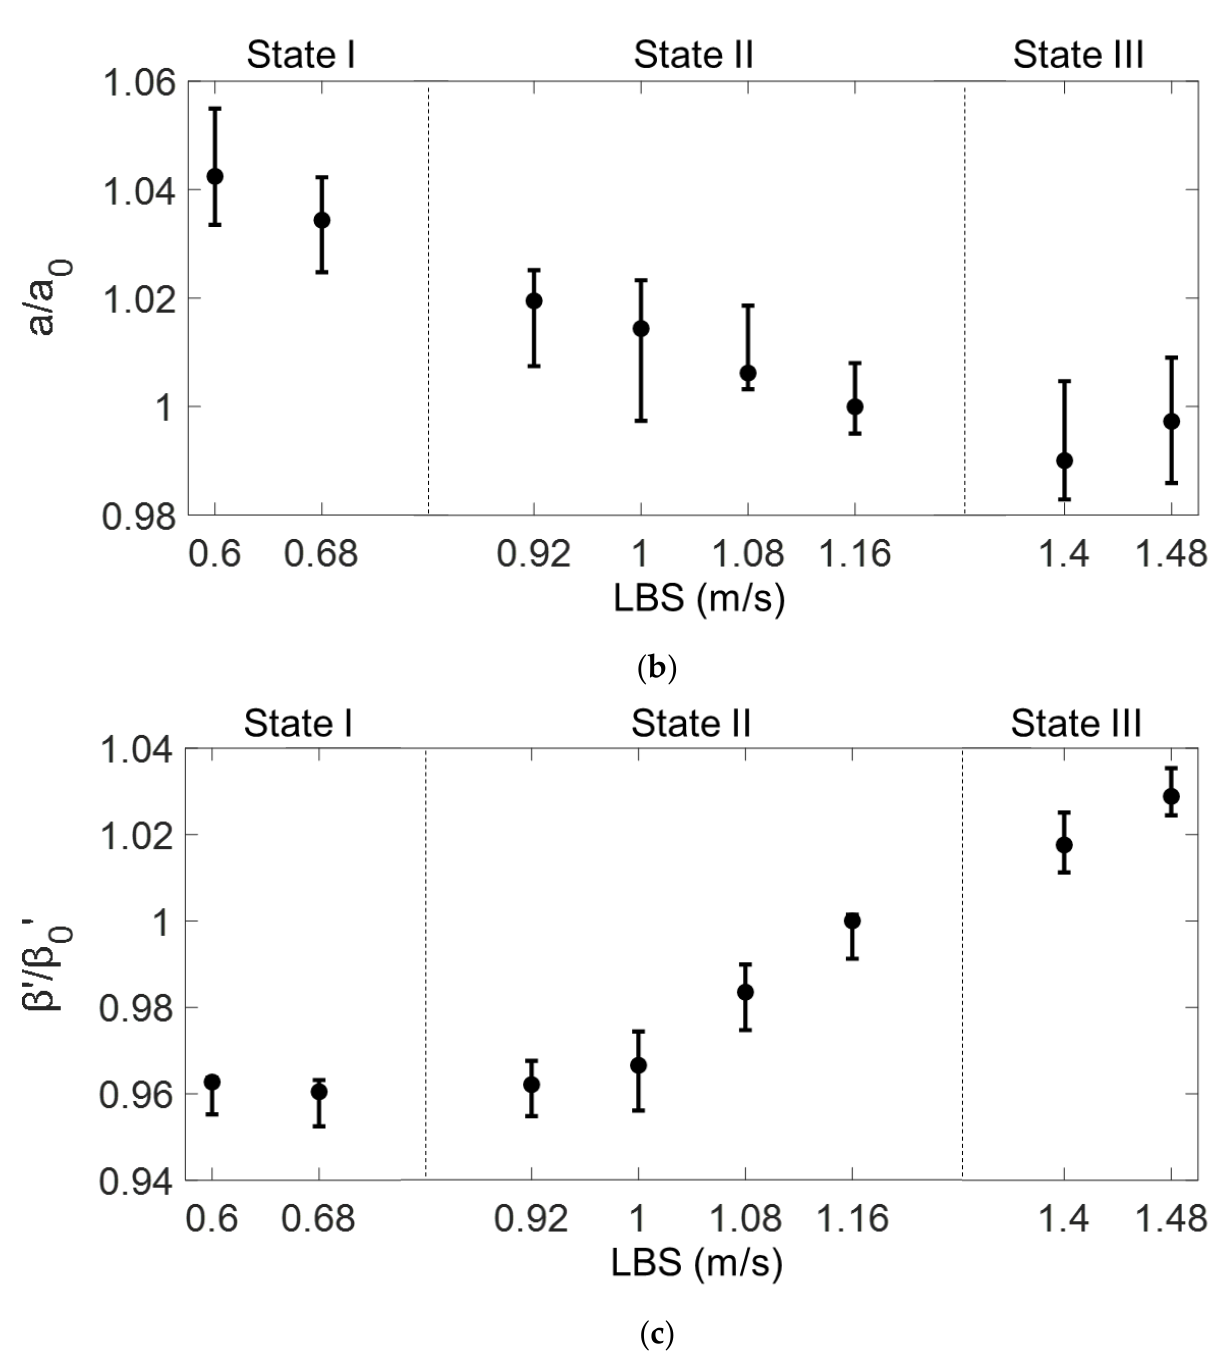
Figure 8. ( a ) Normalized 𝑣 , ( b ) 𝑎 , and ( c ) 𝛽′ parameters measured according to LBS for each State. In Figure 8a, the parameter v increases as the LBS increases from 0.6 to 1.16 m/s (i.e., in State I and II), before sharply decreasing as LBS increases further (i.e., in State III). Although v increased by 0.42% in State II, it sharply decreased by 0.65% in the transition zone of State II and III. At the highest LBS condition of 1.48 m/s in State III, the normalized parameter v was the lowest, i.e., 0.74% less than that at the 1.16 m/s LBS (= v 0 condition). When State I transitions to State II, almost no slope variation is observed. In Figure 8b, a decreases from State I to the first LBS condition of State III, corresponding to an LBS of 0.6–1.4 m/s; however, a reversed trend is observed as the LBS further increases to 1.48 m/s. In Figure